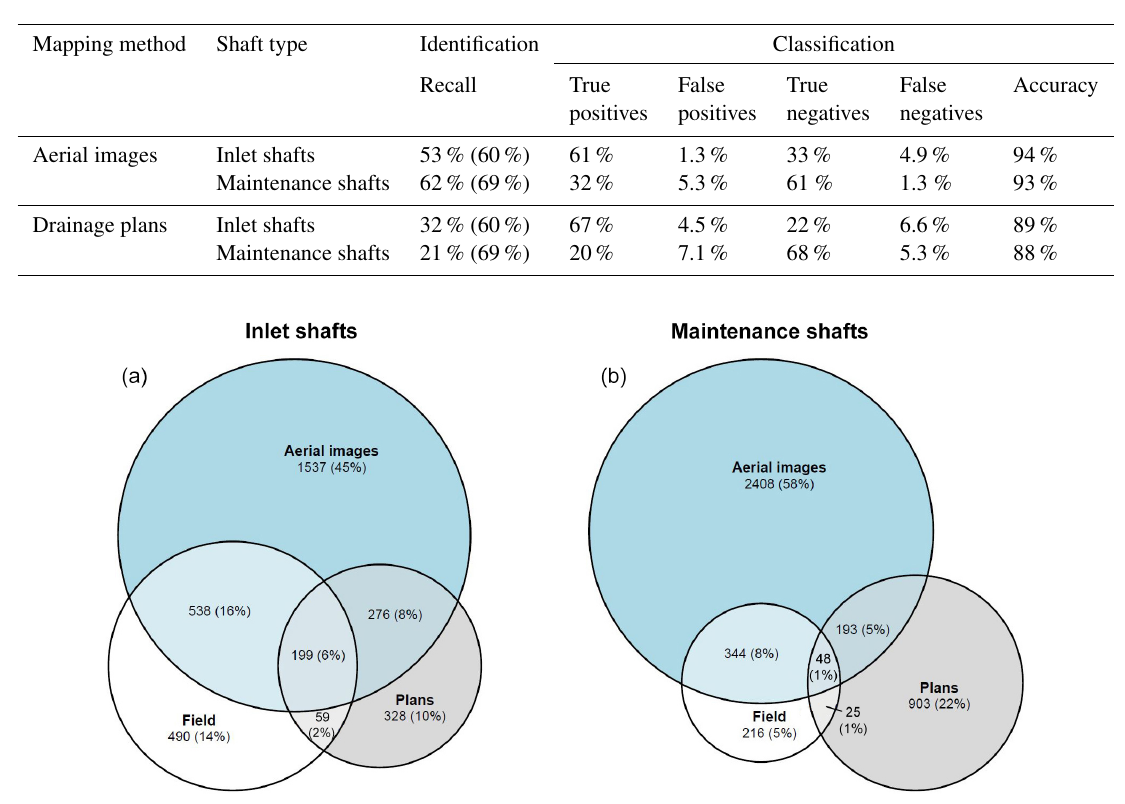
p = 0.23; see Table S8). By contrast, the two study areas